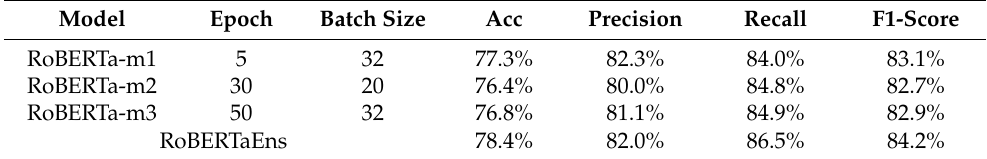
Table 2. Performance of various RoBERTa